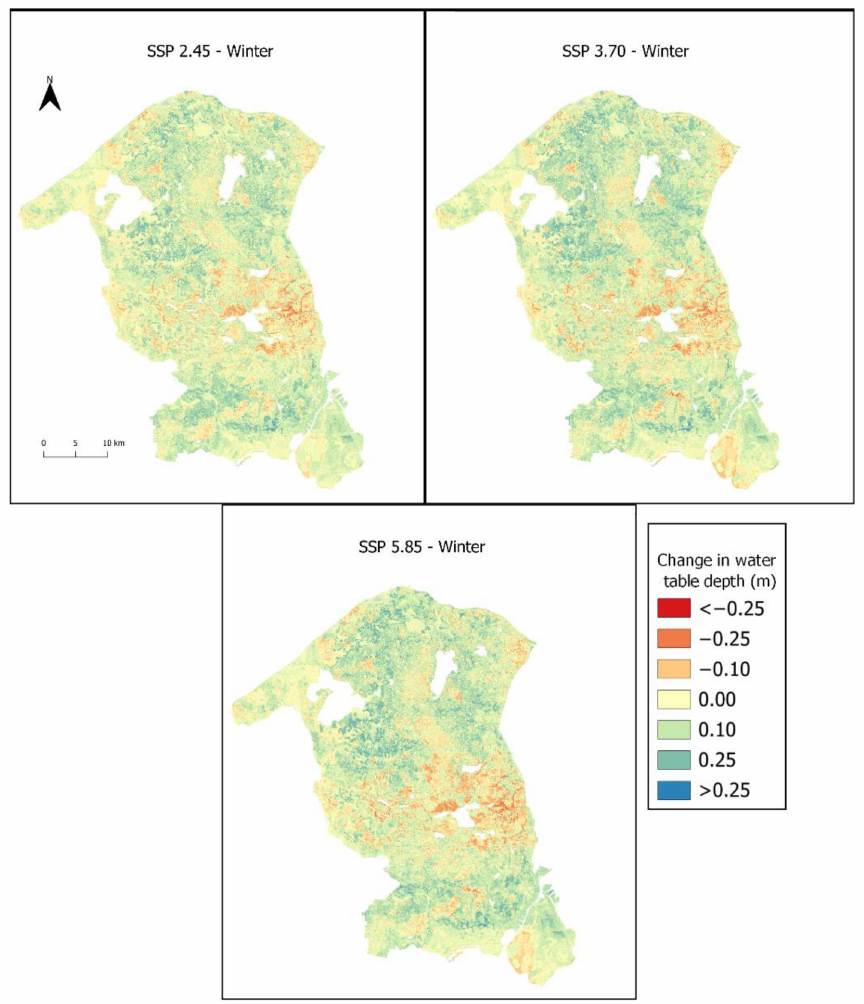
Figure 6. Differential maps showing changes in the water level between the present and each of the future SSPs selected, for the winter season. Positive numbers indicate a rise in the water table, while negative numbers indicate a